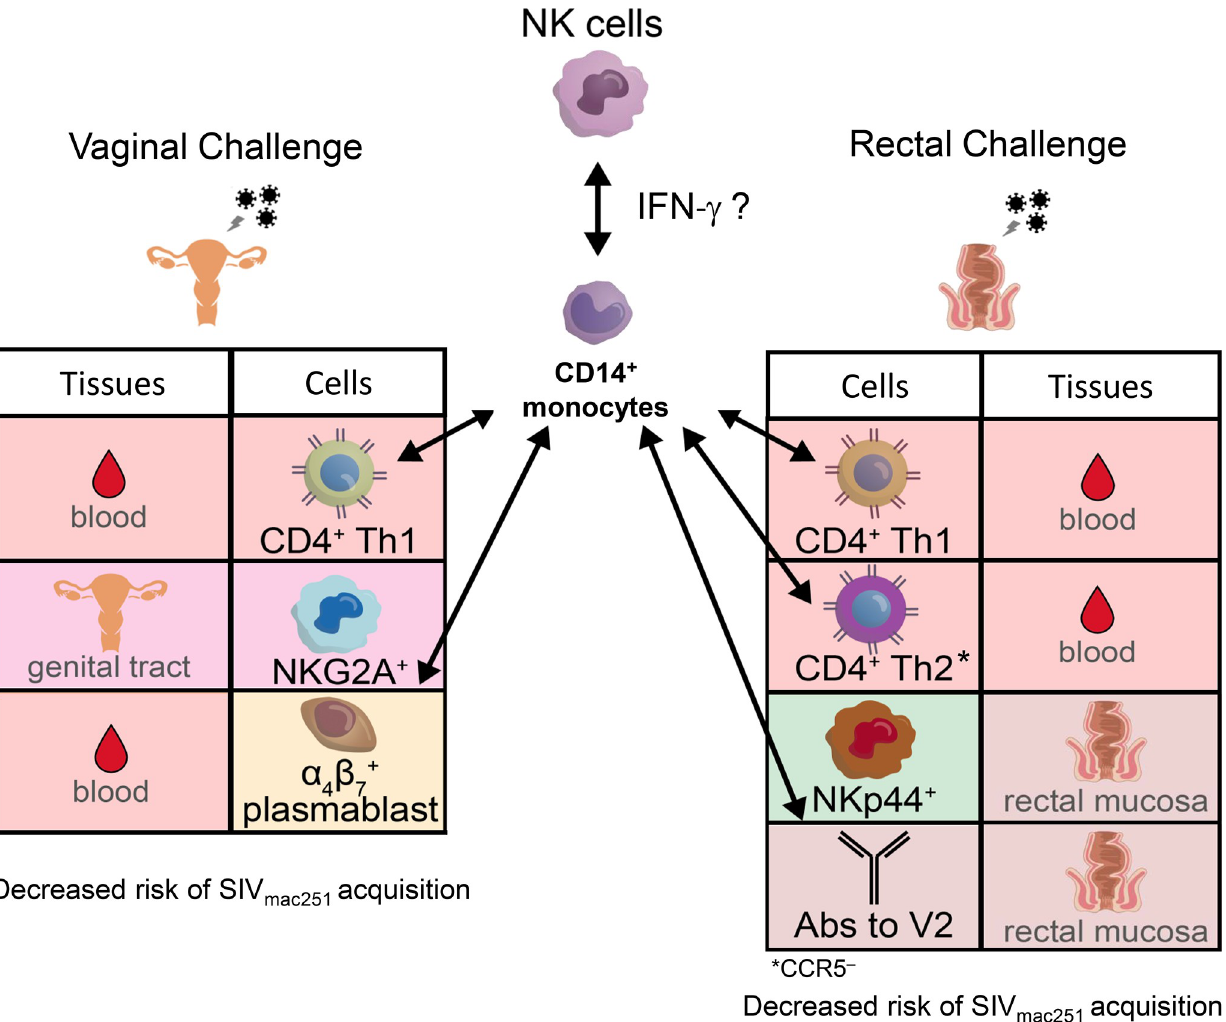
Fig 6. Summary of immune responses that correlated with each other and with virus acquisition. Visual summary of data obtained in the current study (left) and two previously reported independent studies [15, 16]. Vaccine induced cells correlated directly with CD14 monocytes (indicated by arrows) and indirectly with the time of virus acquisition following vaginal (left) and rectal (panel) exposure to the same stock of SIV mac251 .